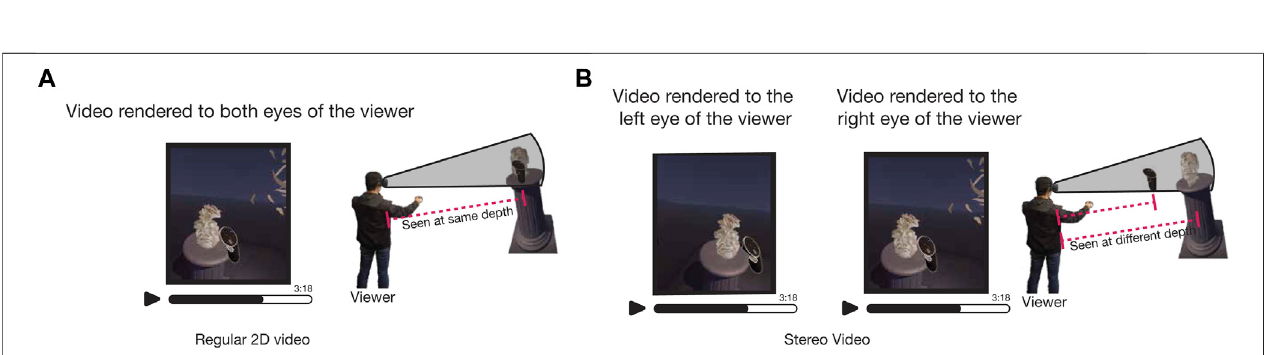
Frontiers in Virtual Reality |